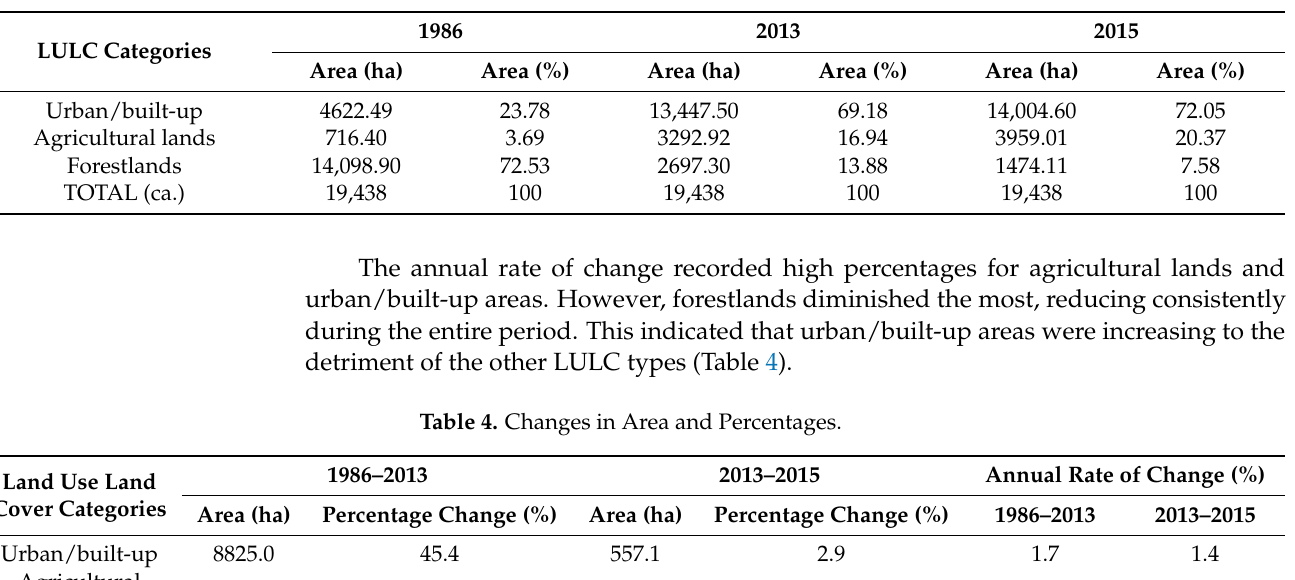
Figure 3. Land Use Land Cover ( LULC) maps for the years 1986, 2013 and 2015. Table 3. Distribution of LULC.